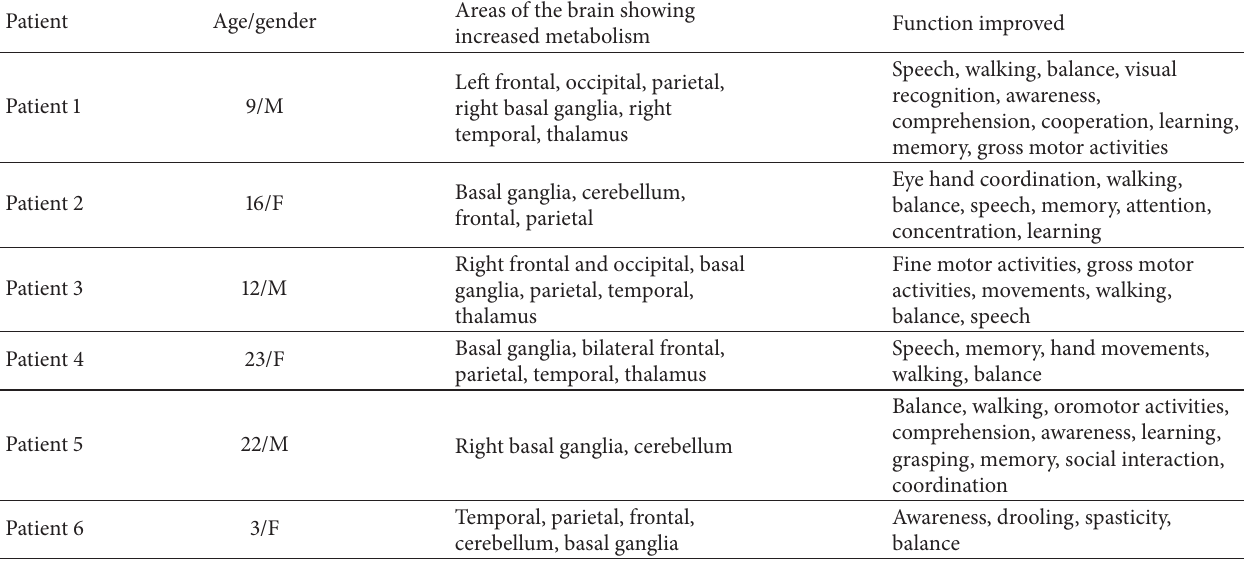
Table 7: Describing the areas of the brain showing increased metabolism in the PET scan, carried out in six patients corresponding to the functional